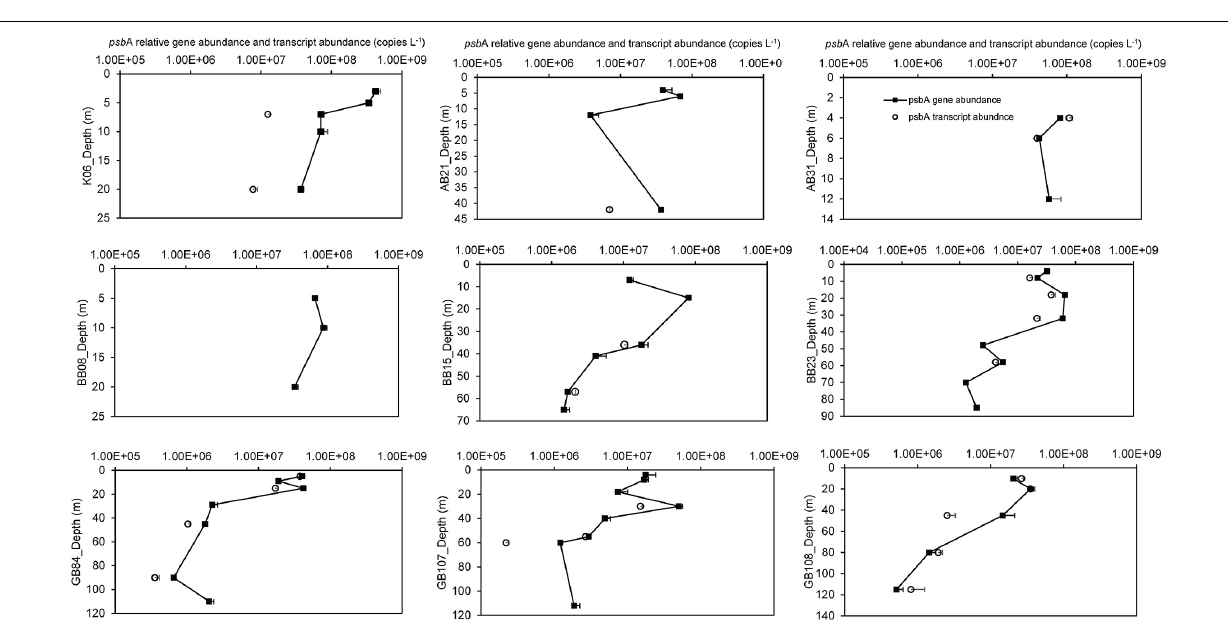
FIGURE 10 | Spatial distribution patterns of gene copy number (DNA) and transcript (mRNA) abundance of the OP photosynthetic gene, psb